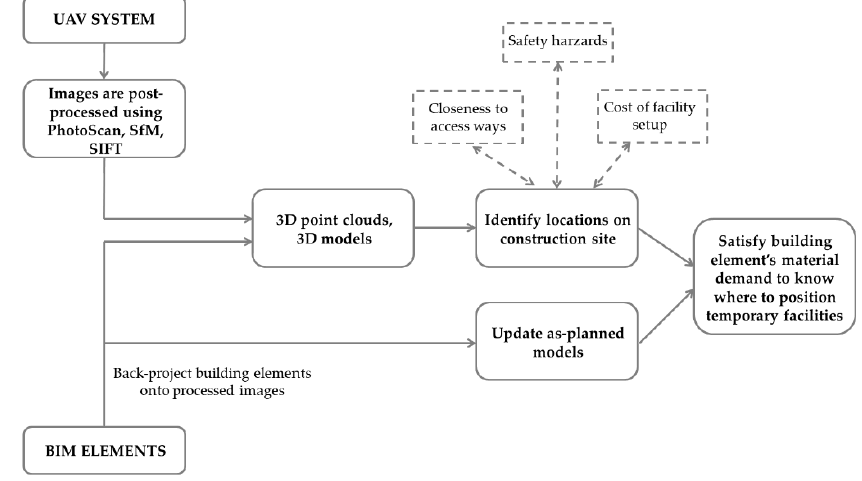
Figure 1. Framework linking different modules for SLP planning.